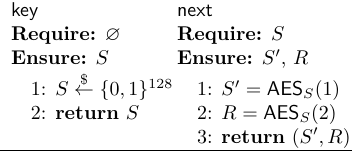
Figure 5: FWD : A Secure